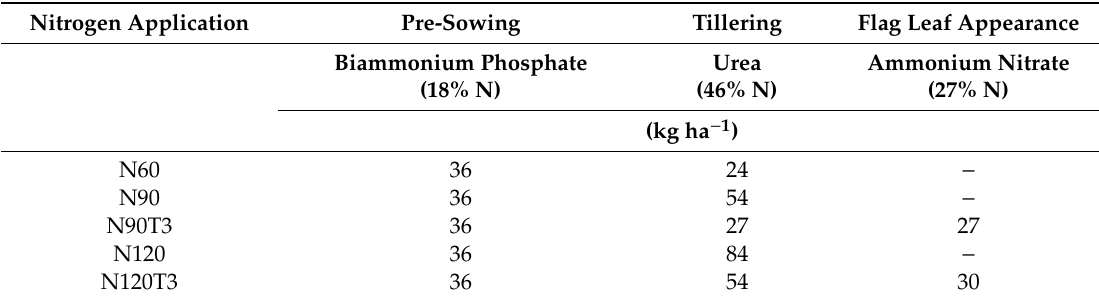
Table 2. Nitrogen fertilizer application